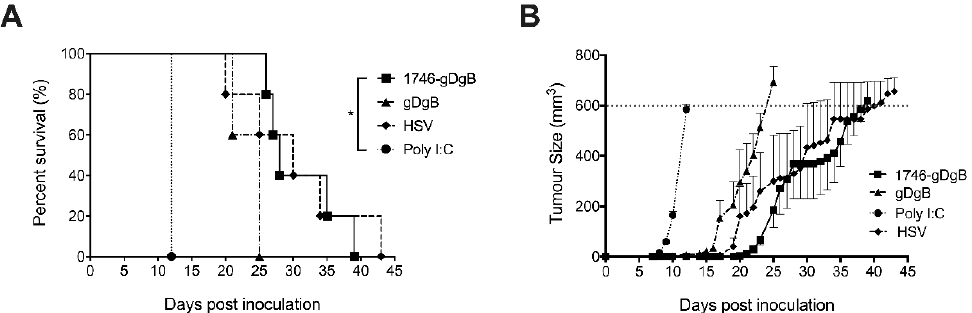
Figure 5. Prophylactic vaccination with a 1746 CPP-linked vaccine construct delays tumor outgrowth and prolongs survival. Treatment schedule: Mice received subcutaneous prime and boost vaccinations with 2 nM of vaccine constructs plus 50 ug Poly(I:C), or HSV infection. One week later, on the opposite flank, mice were subcutaneously inoculated with B16 melanoma cells expressing the HSV-derived antigens gB and gD, contained within the vaccine constructs. No prior transfer of transgenic T cells was given before tumor inoculation. ( A ) Survival plots of mice that received 1746-gBgD vaccine, no-CPP gBgD vaccine, HSV infection or Poly(I:C) alone. ( B ) Growth curves for tumors measured in mm3. Data are from a single experiment and n = 5 mice per group, displayed as mean +/ − SEM. * p < 0.05: Log ‐ rank (Mantel ‐ Cox) test. 1746 ‐ gDgB:Ac ‐ PLKPKKPKTQEKKKKQPPKPKKPKTQEKKKKQPPKPKR ‐